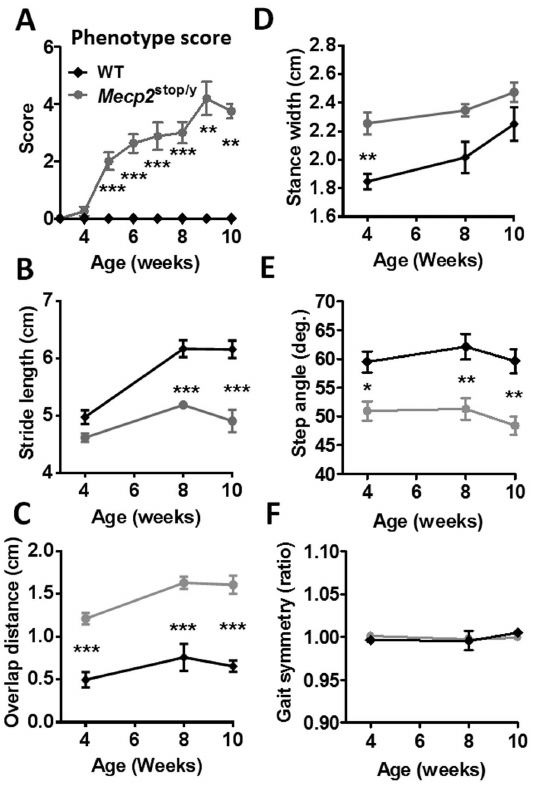
Figure 2. Automated gait analysis reveals early signs of motor defects in Mecp2 stop/y mice. (A) Plot showing aggregate phenotype severity score (mean + / 2 SEM) in male wild-type (WT, black diamond symbols) and Mecp2 stop/y (grey circles) mice. Mecp2 stop/y mice show a gradual phenotype score progression that is significantly different from WT (WT n=7; Mecp2 stop/y n=8 at 3–7 weeks, n=7 at week 8, n=5 at week 9 and n=4 at week 10); decreasing numbers of Mecp2 stop/y mice are explained by early death of some mutant mice. (B–F) Plots showing stride length, overlap distance, stance width, step angle and gait symmetry (mean + / 2 SEM) measured in WT and Mecp2 stop/y mice at 4, 8 and 10 weeks (WT n=7 at 4 weeks and 5 at 8 & 10 weeks; Mecp2 stop/y n=6 at 4 weeks, n=5 at weeks 8 & 10. The treadmill speed was 25 cm/ s. * p , 0.05 ** p , 0.01 *** p , 0.001, Mann Whitney pairwise comparisons (A) and 2-way repeated measures ANOVA with Tukey post hoc pairwise comparisons (B–F).